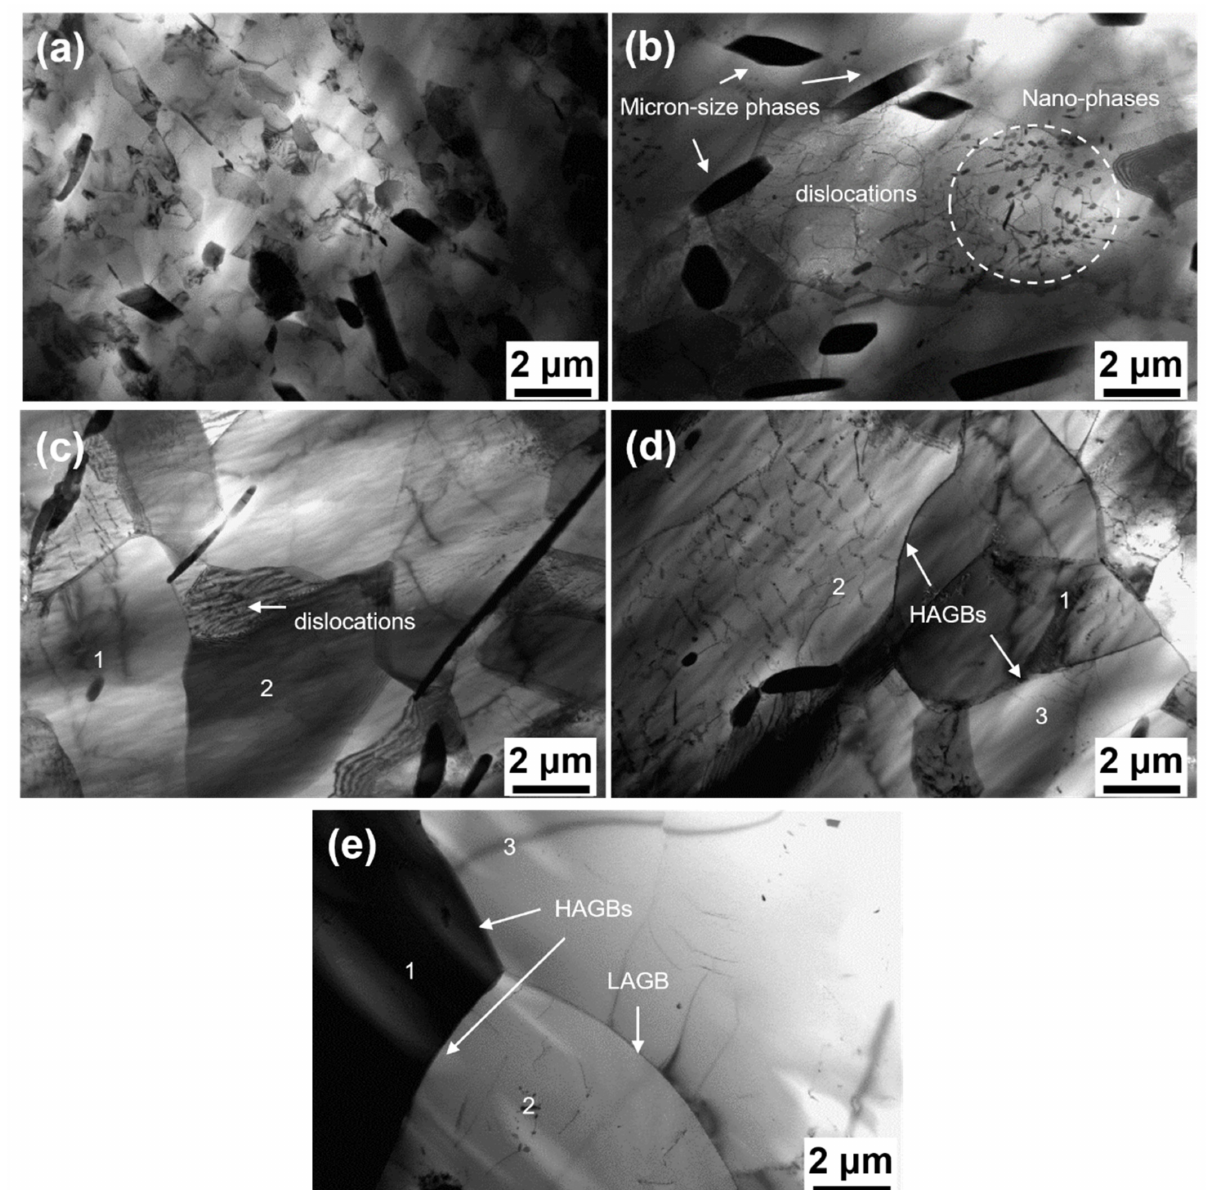
Figure 6. TEM images of the sub-microstructure of spray-deposited 7055 aluminum alloy under hot compression conditions of 300 ◦ C/5 s − 1 ( a ), 300 ◦ C/0.001 s − 1 ( b ), 400 ◦ C/0.1 s − 1 ( c ), 450 ◦ C/5 s − 1 ( d ) and 450 ◦ C/0.001 s − 1 ( e